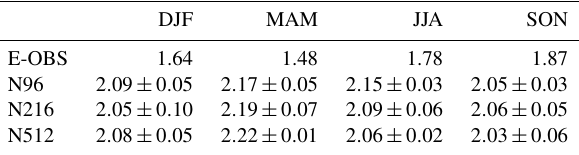
Table 1. Seasonal mean precipitation in Europe in mmday − 1 (land area in − 12–50 ◦ E, 35–72 ◦ N including all model grid boxes with a land fraction greater than 0.5). Based on the ensemble